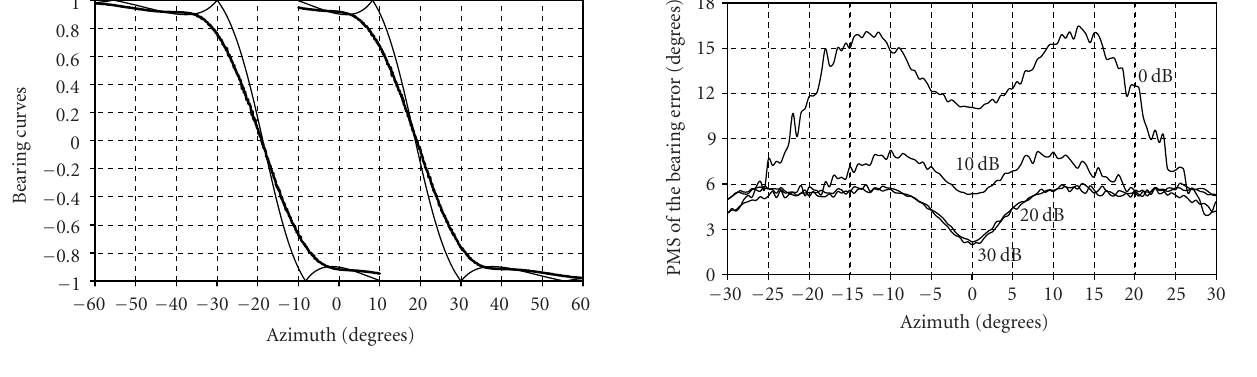
Figure 6: Bearing curves b 21 ( θ ) (left-hand curves) and b 32 ( θ ) (right-hand curves) for the point ( ∆ = 0 ◦ ) and spread ( ∆ = 17 ◦ ) sources (thin and thick curves, respectively).